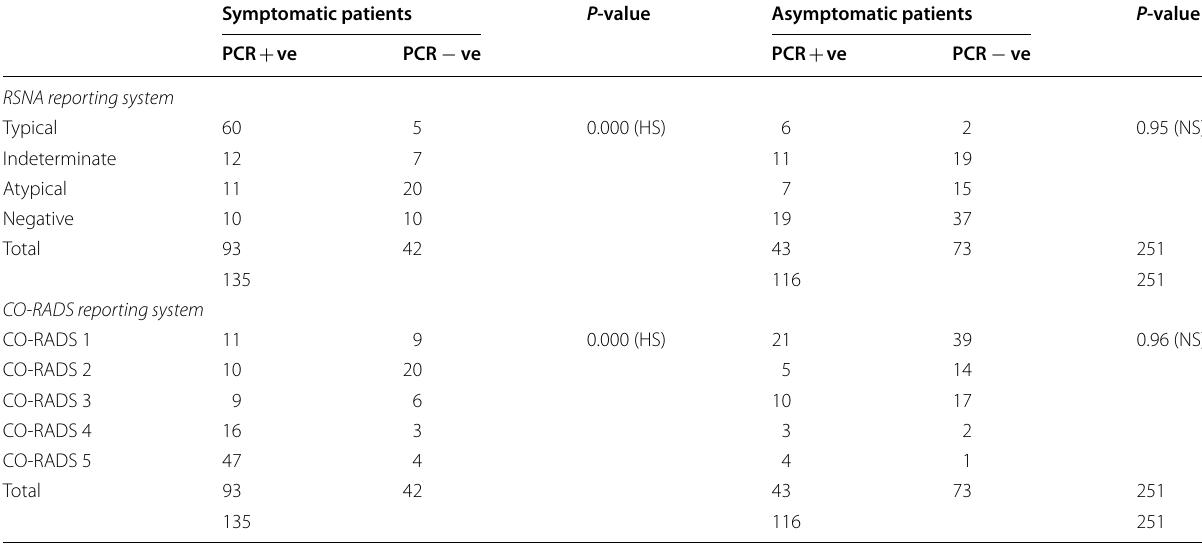
Data are expressed in number. The probability of error ( P -value) at 0.05 was considered significant ( S ), 0.01 and 0.001 are highly significant (HS), while > 0.05 are considered non-significant